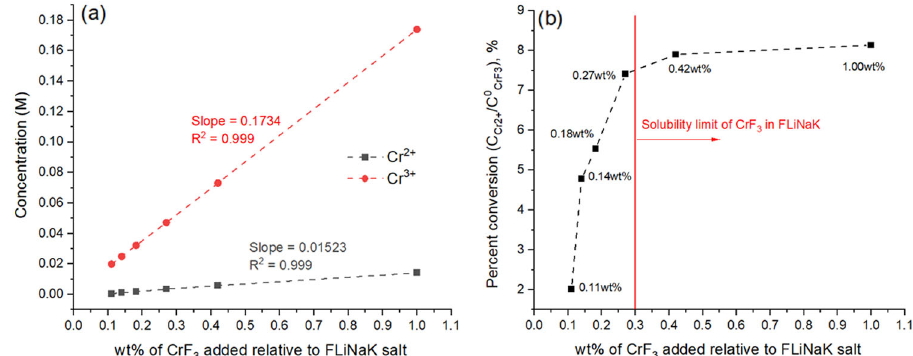
Fig. 2 The concentration of chromium ions calculated using cyclic voltammetry results. a Concentration of Cr 2 + and Cr 3 + species calculated based on Eqs. (18) and (19). b The percent conversion from CrF 3 to Cr 2 + species at a various weight fraction of CrF 3 added to FLiNaK salts. The red line marks the solubility limit of CrF 3 in FLiNaK reported by Yin et al. 39 .